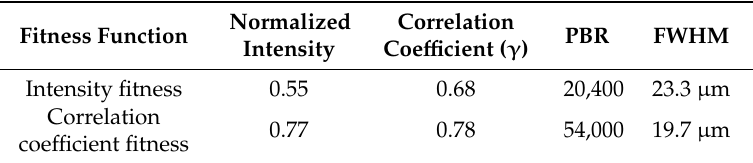
Figure 5. Analysis of experimental results in intensity fitness and correlation coefficient fitness in the MPGA. ( a ) Typical normalized intensity in intensity fitness and correlation coefficient fitness; ( b ) correlation coefficient in intensity fitness and correlation coefficient fitness; ( c ) line profiles of the central rows of focal points in intensity fitness and correlation coefficient fitness. Table 2. Comparison of optimization abilities of two fitness functions.